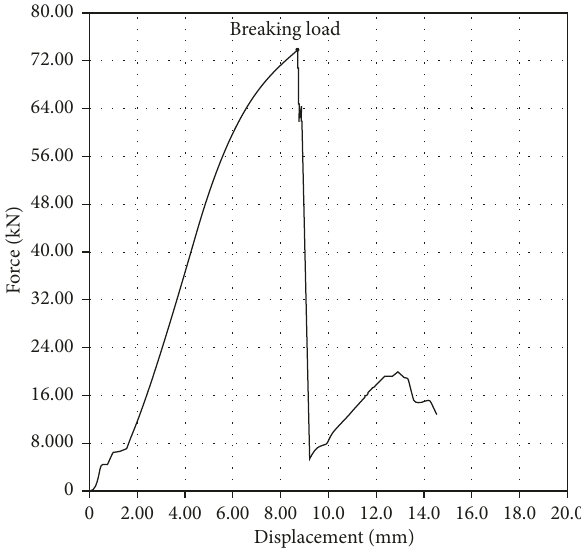
Figure 34: Joint force displacement curve.